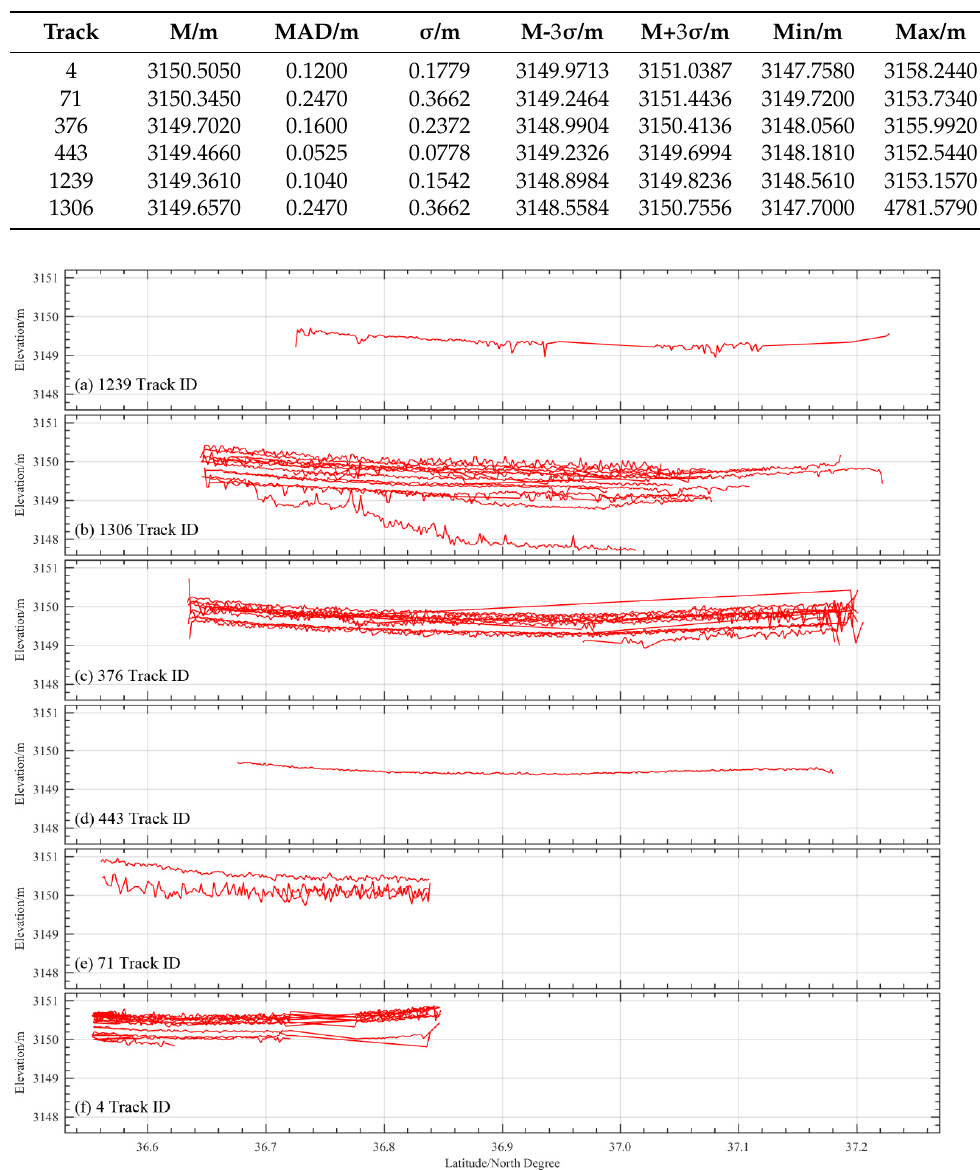
Table 5. The statistical parameters of the MAD outlier method used in each combined track.